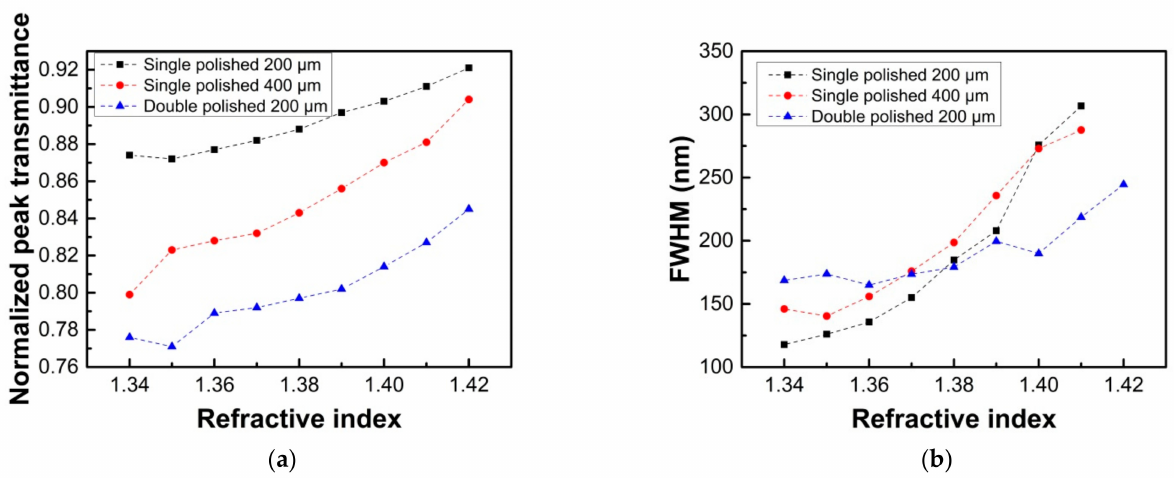
Figure 10. The transmitted intensity of the sharpest SPR peak ( a ), and the full width at half maximum (FWHM) of normalized transmission spectra ( b